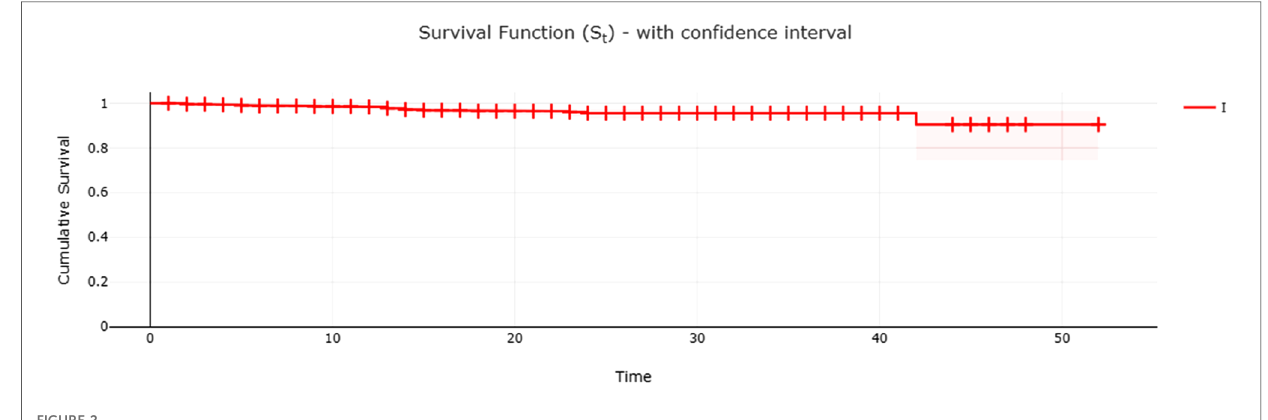
FIGURE 2 Kaplan – Meier curve for the event of implant loss in the sample evaluated.